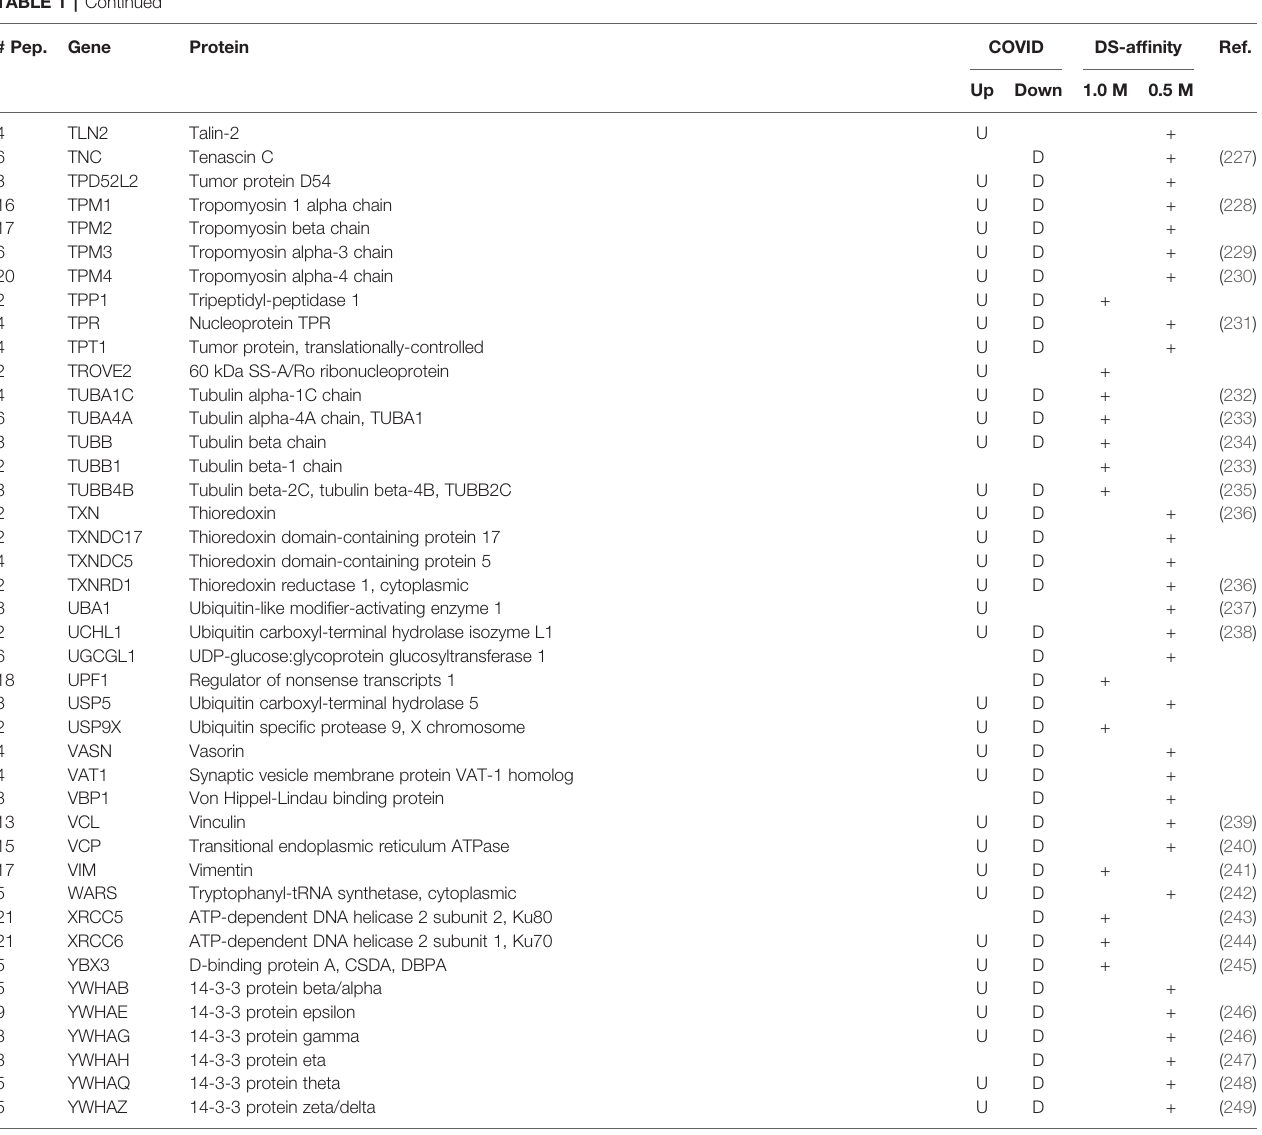
# Pep., number of peptides identi fi ed by mass spectrometry; COVID (Up/Down), protein or gene expression up- and/or down-regulated in SARS-CoV-2 infected cells or patients; DS- af fi nity, concentration of NaCl (1.0 M, very high af fi nity, or 0.5 M, medium to high af fi nity) at which a DS-binding protein elutes from DS-af fi nity